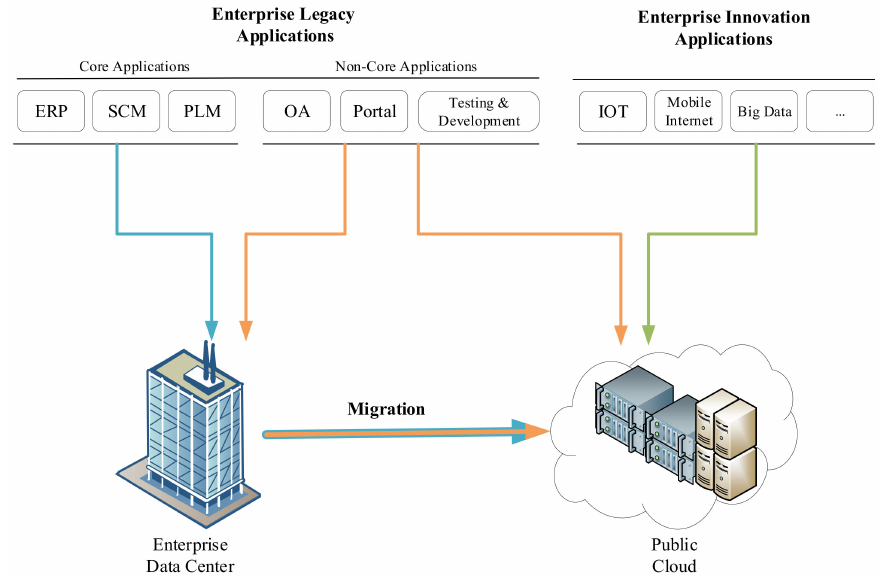
Figure 1. Recommendations for enterprise application migration to the